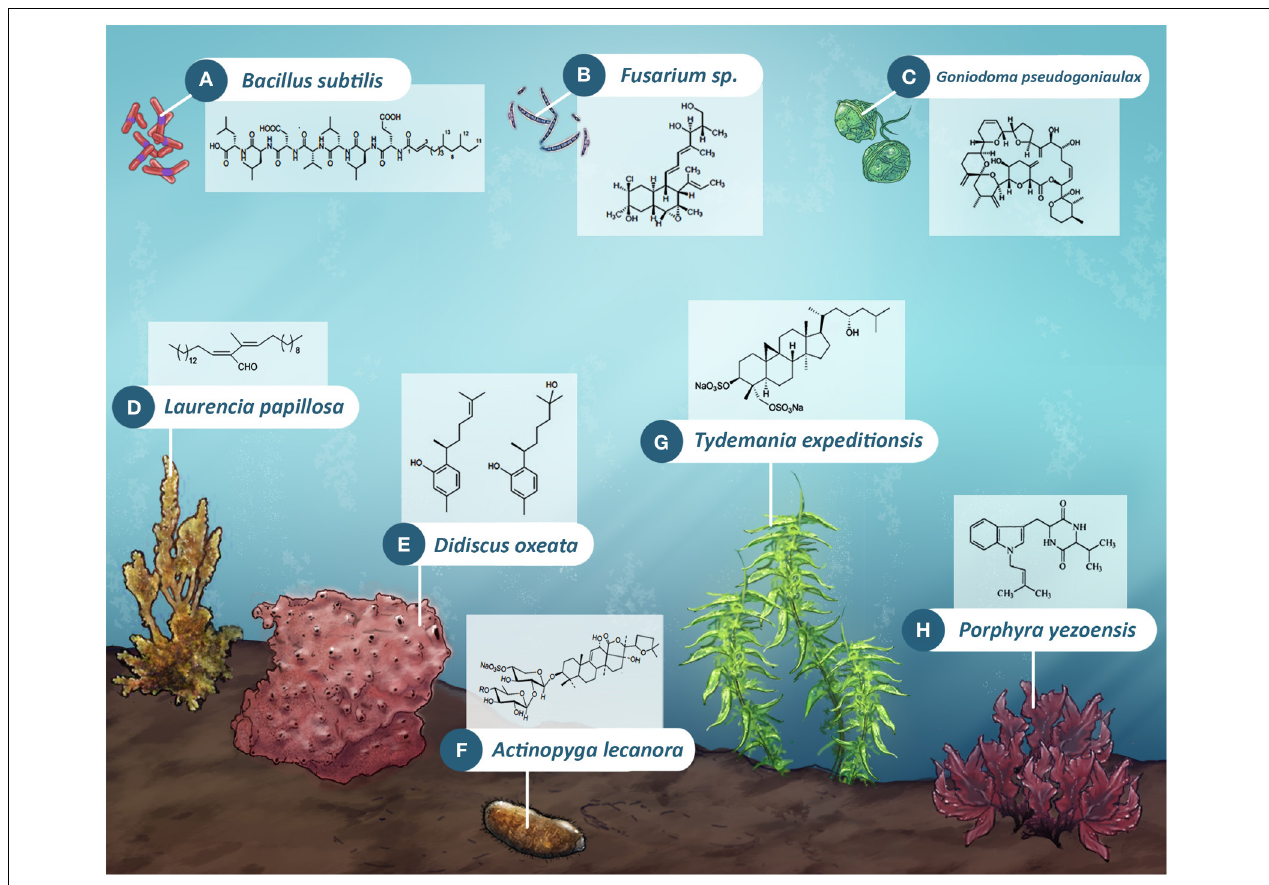
FIGURE 1 | Natural products from marine organisms with significant activity against fungal strains of health and economic relevance. They can be found in marine-derived bacteria (A–Gageosatins C, a linear lipopeptide), fungi (B–Fusarielin E, a fusaricidin derivative), dinoflagellates (C–Goniodomin A, a polyether macrolide compound), red alga (D–Aldehyde derivative (E)-2-{(E) tridec-2-en-2-yl} heptadec-2-enal), sponge (E–Curcuphenol